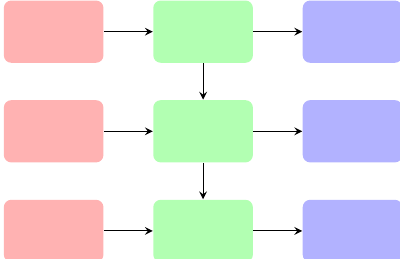
Figure 3. Many-to-many architecture of the LSTM algorithm. Rectangles represent vectors and arrows represent functions. Based on